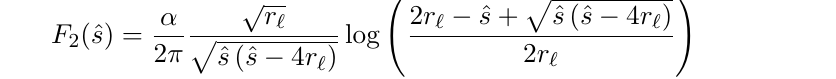
= [(cid:22) s(cid:27) (cid:22)(cid:23) b ] F D and Q DP = [(cid:22) ‘(cid:27) (cid:22)(cid:23) ‘ ] F D with F D the (cid:22)(cid:23) (cid:22)(cid:23) (cid:22)(cid:23) 7 ‘